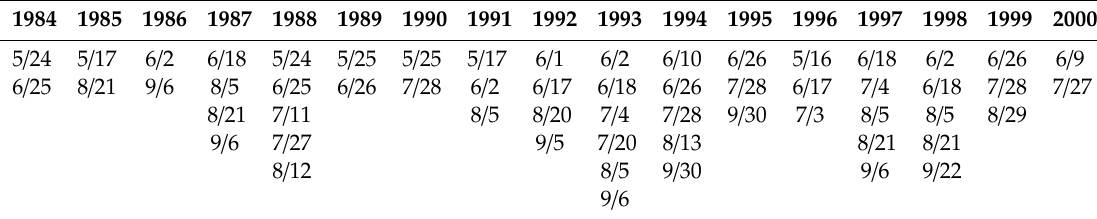
Table 1. Dates of Landsat 5 satellite imagery for BULC-U time series creation.